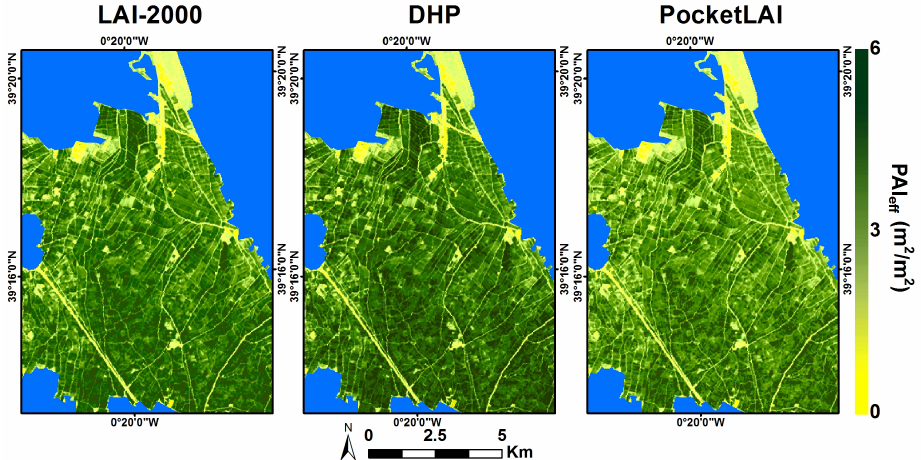
Figure 5. PAI ef f -derived maps using a transfer function and Landsat-8 data (DoY = 196, year 2014) using PAI LAI 2000 ( left ); PAI DHP ( middle ); and PAI APP ( right ) data sets. ef f ef f ef f